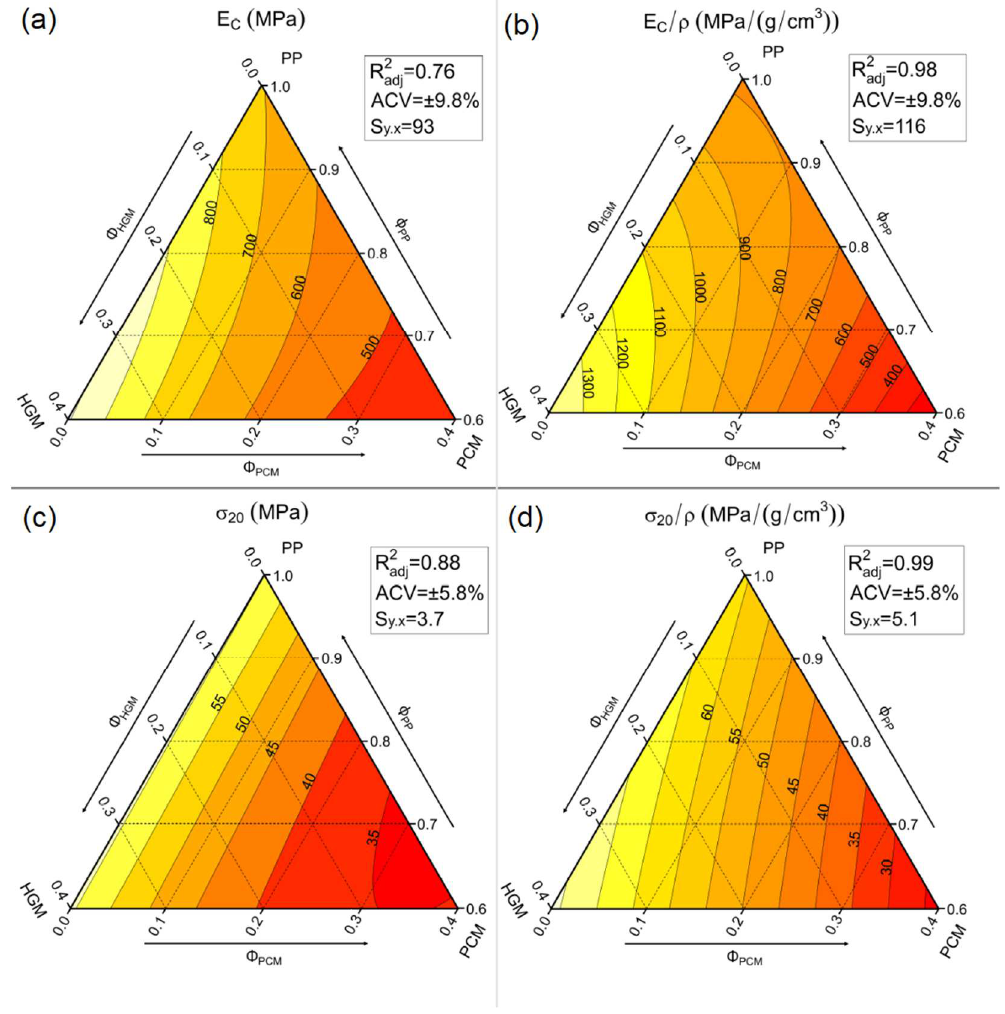
Figure 12. Ternary diagrams of the quasi-static compressive properties of the prepared syntactic foams. ( a ) Compressive modulus (E C ), ( b ) specific compressive modulus (E C / ρ ), ( c ) compressive stress at 20% (σ 20 ), and ( d ) specific compressive stress at 20% (σ 20 / ρ